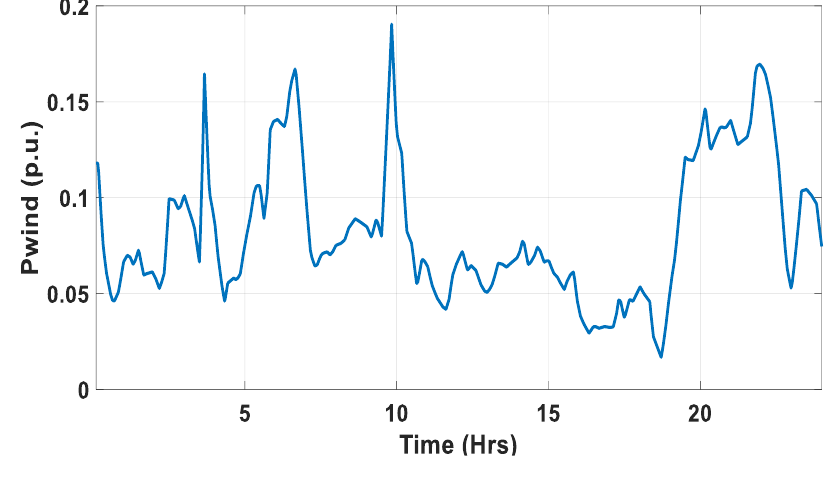
Figure 14. Dynamic response using different controllers under random load variation: ( a ) ΔF 1 , ( b ) ΔF 2 , and ( c ) ΔP tie .